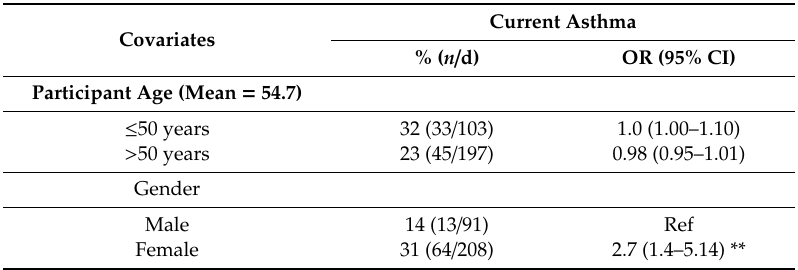
Table 2. Univariate analyses between covariates and